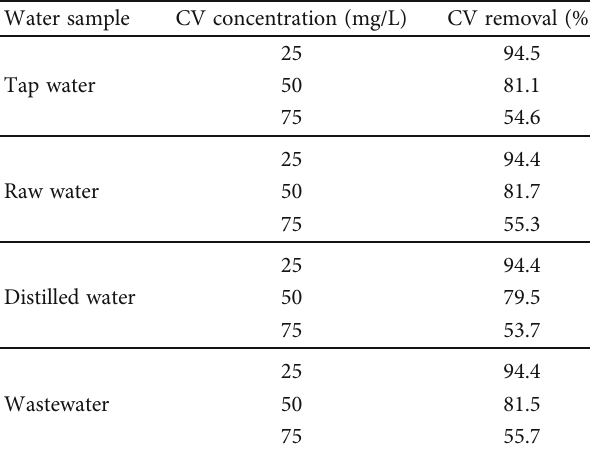
Table 15: CV adsorption onto ACMAS in real water